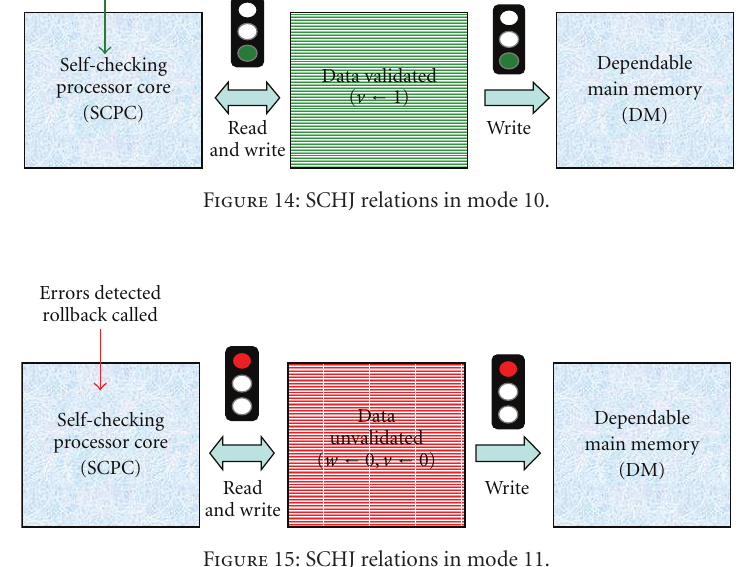
Figure 15: SCHJ relations in mode